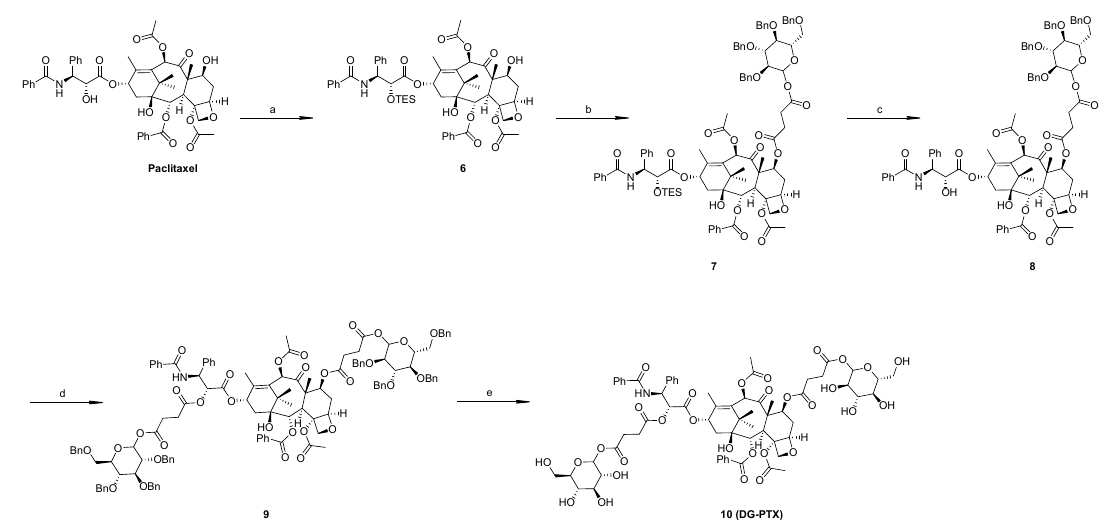
Scheme 2. Synthesis of double glucose-conjugated paclitaxel (DG-PTX). Reagents and conditions: (a) TESCl, imidazole, 4 h, 66%; (b) compound 3 , DMAP, DCC, THF, 24 h, 53%; (c) TBAF, THF, 6 h, 66%;